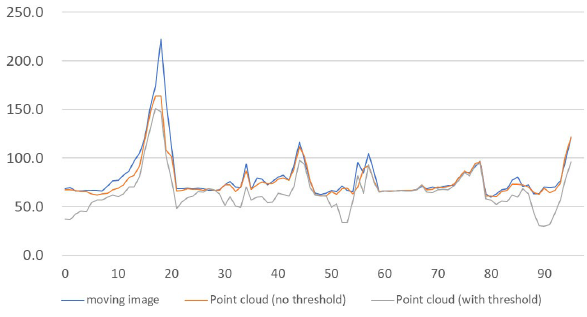
Figure 10 . The statistics of the VQM model